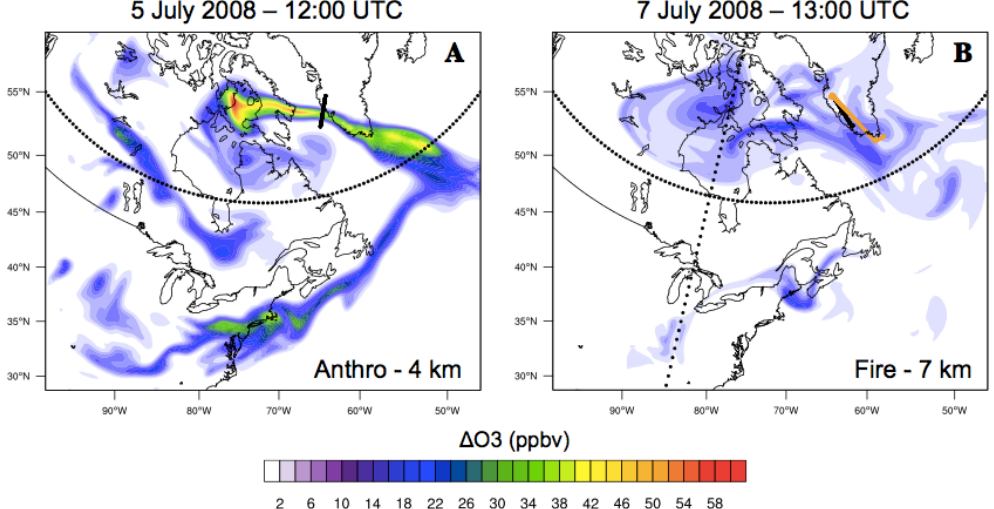
Fig. 11. Maps of enhancements in ozone in anthropogenic and fire plumes ( 1 O 3 ) demonstrating the spatial extent of plumes sampled by the ATR-72 and Falcon-20 on 5 and 7 July 2008. The ATR-42 aircraft flight tracks are in black and the Falcon-20 flight track is in orange. For anthropogenic plumes, the latitude 55 ◦ N that is used to define fresh ( < 2km, lat < 55 ◦ N) and aged (lat > 55 ◦ N) anthropogenic plumes is indicated by the dotted black line. For fire plumes, the latitude 55 ◦ N longitude 85 ◦ W (used to define aged fire plumes) are indicated by dotted black lines. These same plumes are shown as enhanced CO mixing ratios in Fig. 2, panel ( d ) for the anthropogenic emissions and panel ( e ) for